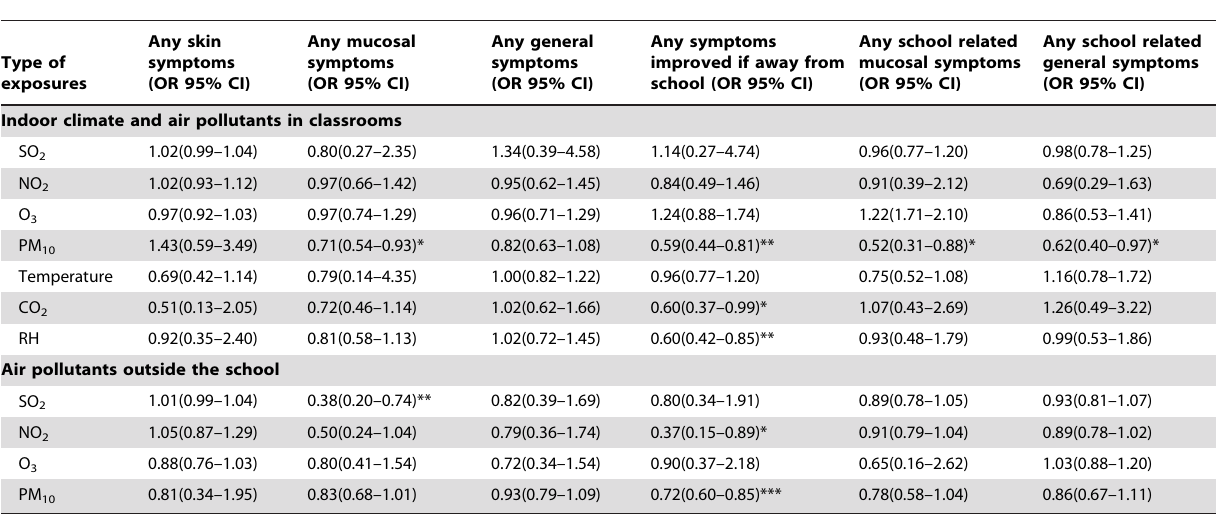
Table 9. Associations between measured environmental factors and remission of weekly symptoms during the two-year follow-up from 2010 to 2012